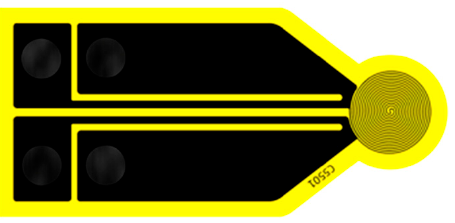
Figure 4. Appearance of Kapton-insulated Hot Disk sensor.